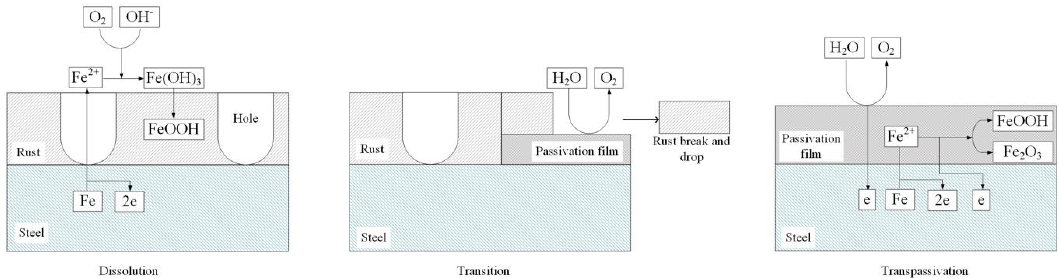
Figure 12. Reaction model of anodic polarization behavior of X80 steel in 4 g·L − 1 Na 2 SO 4 solution.